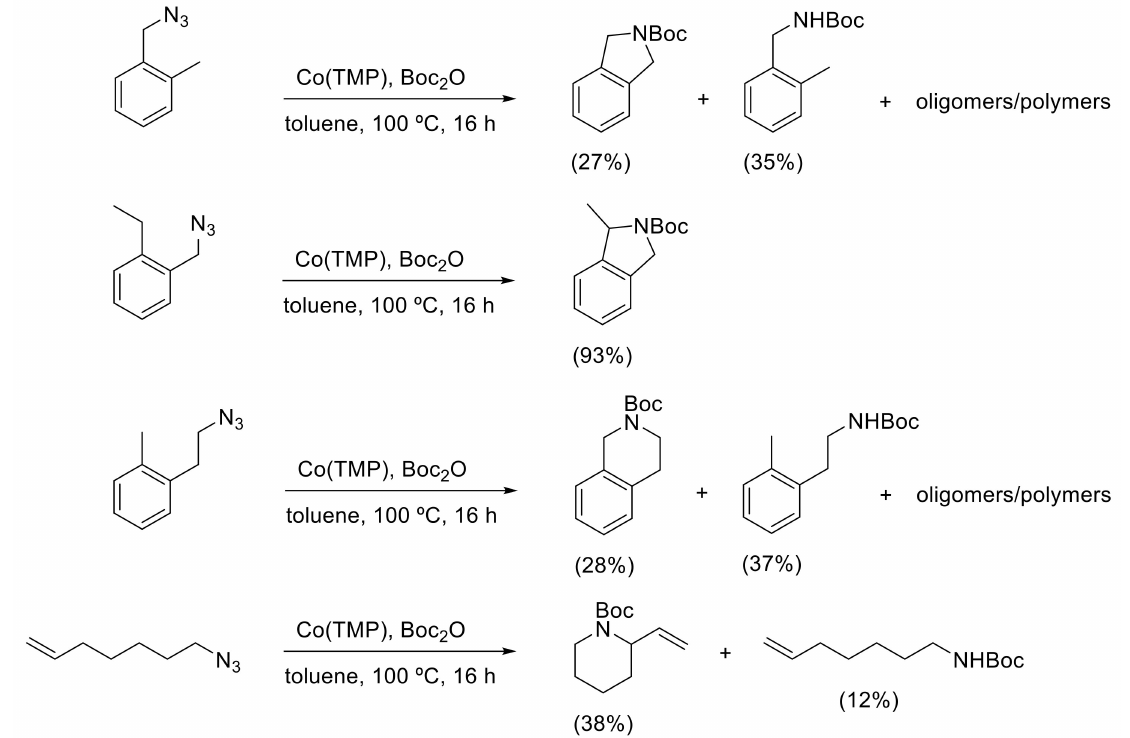
reaction for the synthesis of other